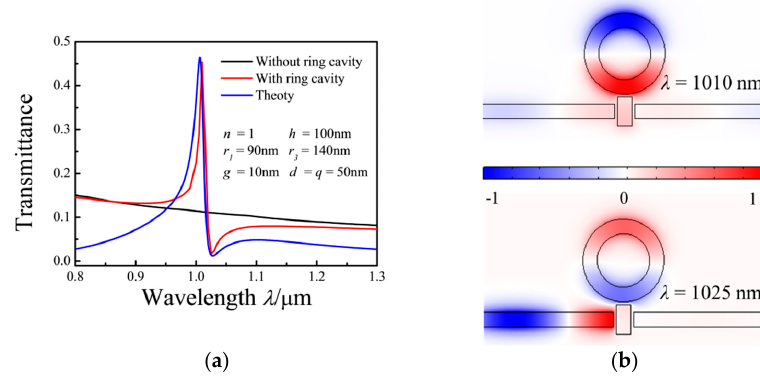
Figure 3. ( a ) Transmission spectra of the MIM waveguides coupled with ring and rectangular cavities (red curve) by a rectangular cavity only (black curve); ( b ) contour profiles of the normalized H z field distributions in the MIM waveguides coupled with ring and rectangular resonators with λ = 1010 nm (top) and λ = 1025 nm (bottom).